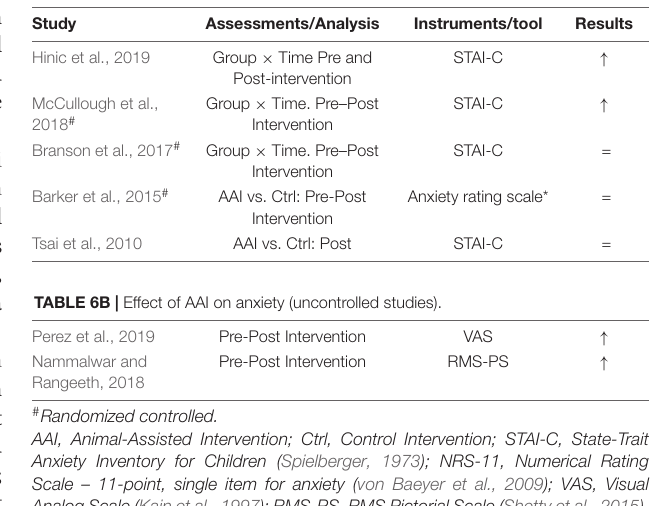
TABLE 6A | Effect of AAI on anxiety (controlled studies).